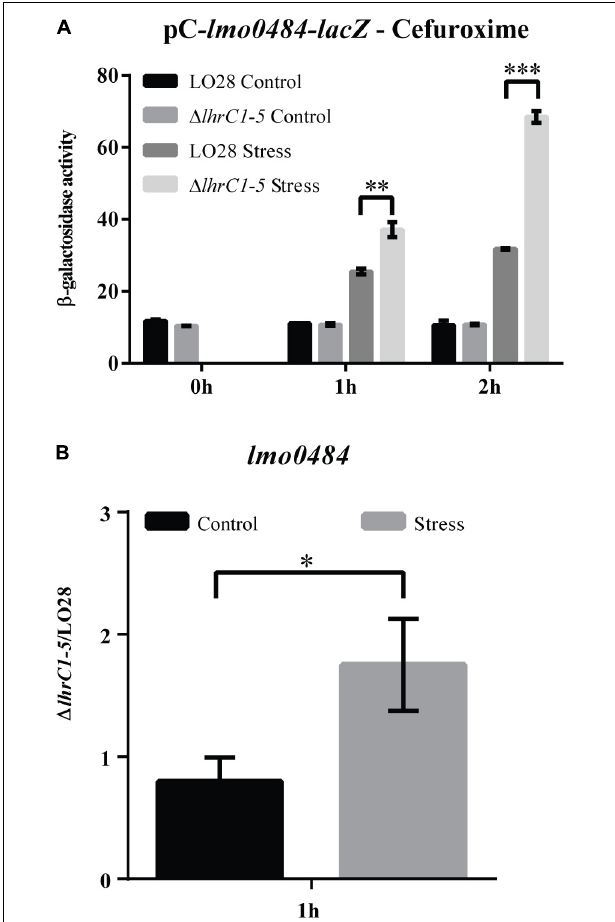
FIGURE 7 | Assessing the effect of LhrC1–5 on the novel target gene lmo0484 upon cefuroxime exposure. (A) β -galactosidase assay of LO28 wild-type and (cid:49) lhrC1–5 strains carrying a translational reporter gene fusion of lmo0484 to lacZ in the vector pCK-lac. β -galactosidase activities of LO28 wild-type and mutant cells were measured at the indicated time points under non-stress conditions (Control) and after exposure to 9 µ M cefuroxime (Stress). The results are the average of three biological replicates, each carried out in technical duplicates. After 1 and 2 h of stress, a significant difference between the mutant and wild-type cells was observed ( ∗∗ p < 0.001; ∗∗∗ p < 0.0001). (B) Quantification of lmo0484 mRNA in (cid:49) lhrC1–5 relative to LO28 wild-type by RT-qPCR. The ratio of (cid:49) lhrC1–5 /LO28 was determined at the 1 h time point for both non-stressed (Control) and cefuroxime-exposed samples (Stress). The result shown is the average of three biological replicates. The asterisk indicates a significant increase of the ratio under stress conditions compared to the control with p <